Question: What visual encoding does this figure use to show its data?
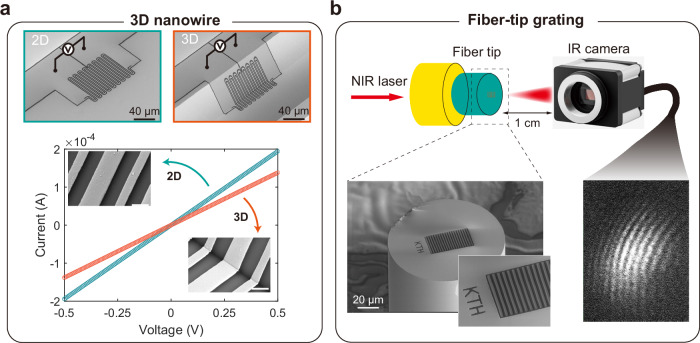
Answer: line